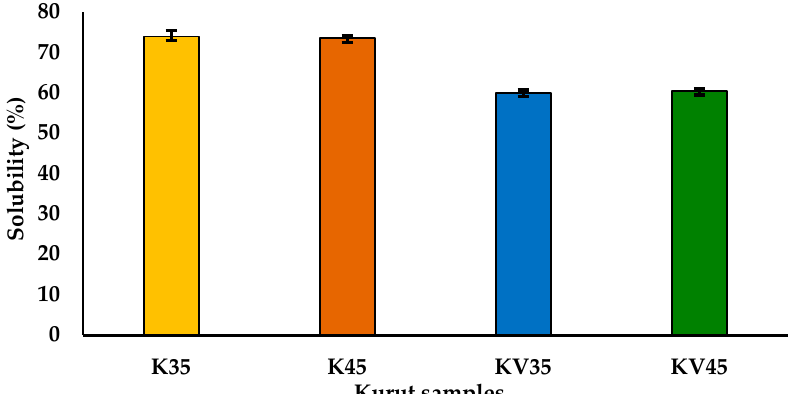
Figure 3. Change of solubility ratio (%) of Kurut samples dried by VOD and OD techniques at 35 °C and 45 °C ( p ˃ 0.05), (K35— Kurut sample OD applied at 35 °C; K45— Kurut sample OD applied at 45 °C; KV35— Kurut sample VOD applied at 35 °C; KV45— Kurut sample VOD applied at 45 °C).